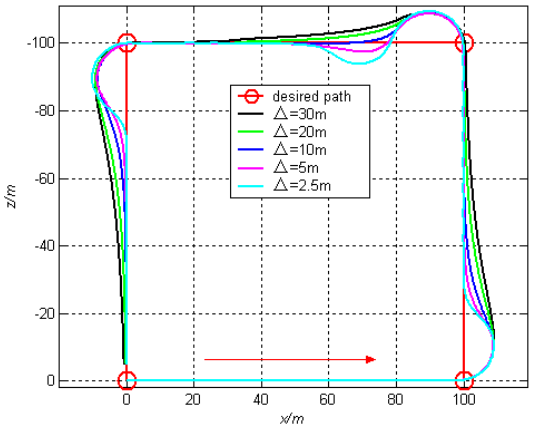
Figure 12. Waypoint selecting criterion with along-track distance.